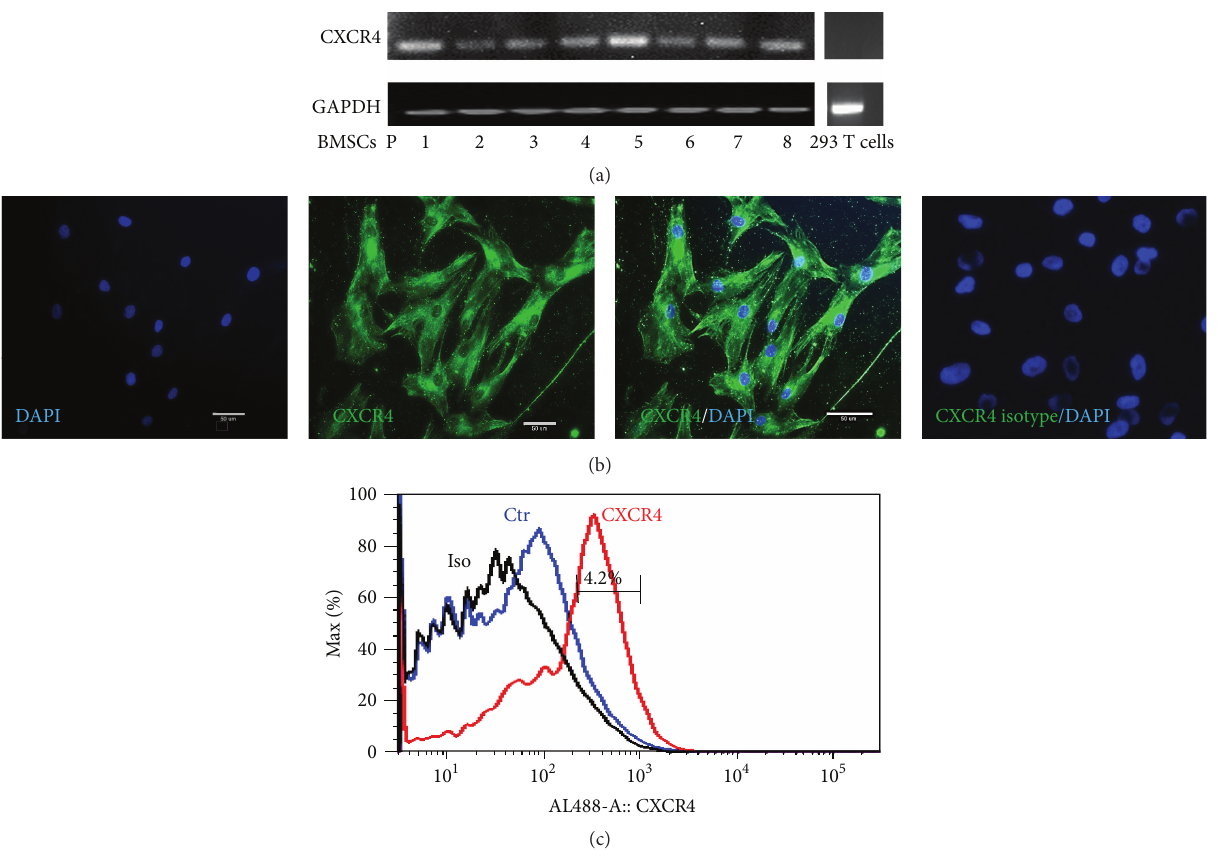
Figure 1: Expression of CXCR4 in BMSCs. (a) RT-PCR results of CXCR4 expression in BMSCs from passages 1 to 8; CXCR4 was stably expressed; 293T cells as negative control; (b) immunocytochemistry results of CXCR4 expression, which indicated both membrane and intracellular CXCR4 expression; (c) the result of flow cytometry indicated only 4.2% of cells were positive for membrane